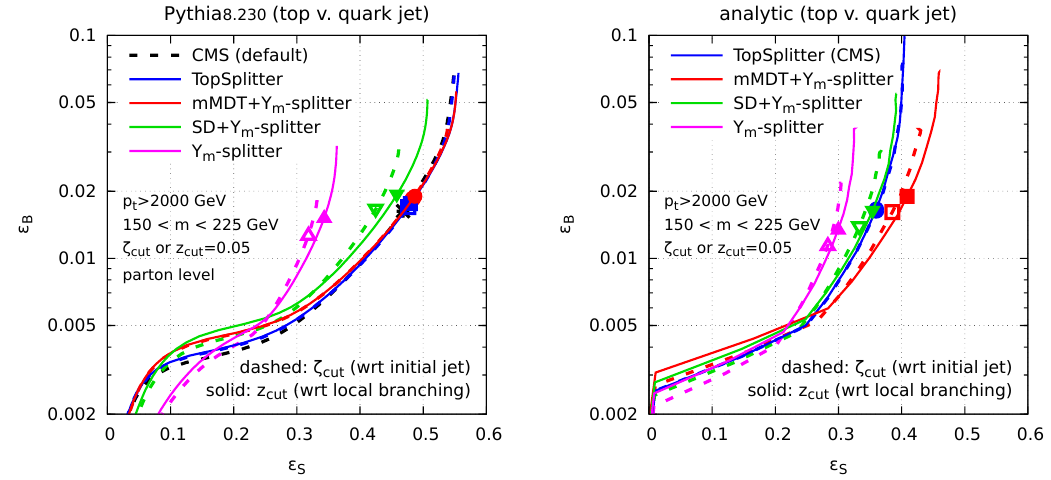
Figure 13. Comparison of the taggers performance when using a z cut condition (solid lines) compared to the default (cid:16) cut condition (dashed lines). Left: Pythia simulations, right: our analytic